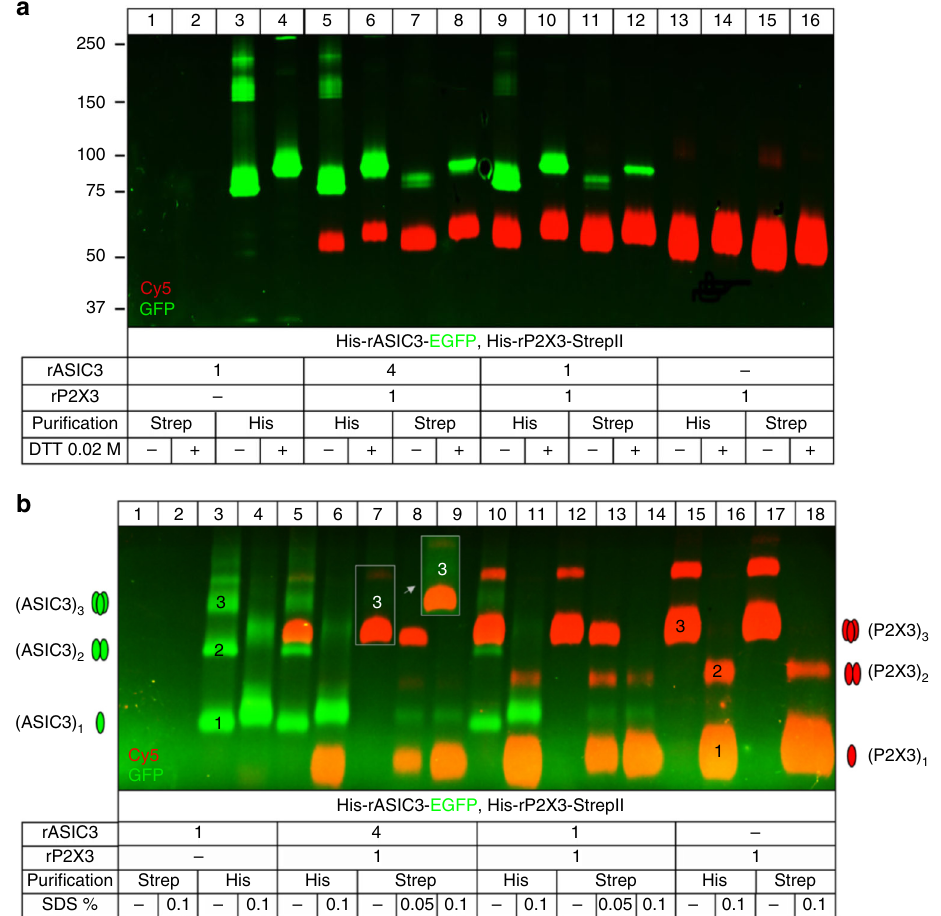
Fig. 9 Plasma membrane expression and oligomeric assembly of rASIC3 and rP2X3R subunits in oocytes. For biochemical analysis, Xenopus (X.) laevis oocytes expressing the indicated proteins were surface labeled with the membrane-impermeant fl uorescent Cy5 dye before protein puri fi cation. The indicated proteins were puri fi ed under non-denaturing conditions from X. laevis oocytes by Ni 2 + -NTA chromatography or Strep-Tactin chromatography, as indicated, resolved by SDS-PAGE ( a ) or BN-PAGE ( b ), and visualized by Typhoon fl uorescence scanning. a Overlay of the Cy5-labeled surface form (red) of the His-rASIC3-EGFP and His-rP2X3-StrepII protomers and the GFP fl uorescence (green) of the His-rASIC3-EGFP protomer. The positions of molecular mass markers (in kDa) are shown on the left. b Overlay of GFP and Cy5 fl uorescence of the homomeric His-rASIC3-EGFP (lanes 1 – 4) and homotrimeric His-rP2X3-StrepII (lanes 15 – 18) and the co-expressed His-rASIC3-EGFP and His-rP2X3-StrepII receptor subunits (lanes 5 – 14) in their native or partial SDS- denatured forms isolated by Ni 2 + -NTA (lanes 3 – 6, 10, 11, 15, 16) or Strep-Tactin (lanes 7 – 9, 12 – 14, 17, 18) chromatography as indicated. Co-expression of rASIC3 and rP2X3 (lanes 5 – 14) originates from the co-injection of the His-rASIC3-EGFP and His-rP2X3-StrepII subunit in cRNA ratios as indicated. The number of protomers included in the respective bands are exemplarily indicated. The inset shows the indicated section of the gel with enhanced GFP fl uorescence to enable the visibility of the ASIC3 trimer. The schematics and labeling on the left or right margins indicate the numbers of rASIC3 or rP2X3 protomers incorporated in the respective trimeric (bold) or dimeric or monomeric protein band of the rASIC3 or rP2X3 receptor complexes,